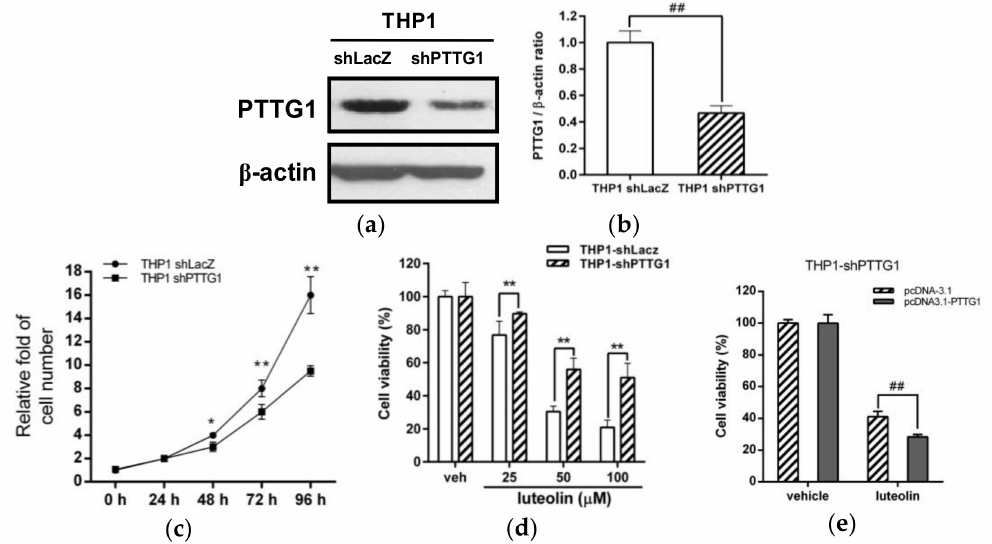
Figure 5. Effects of PTTG1 knockdown on cell proliferation and luteolin-induced cell death in THP-1 cells. ( a ) Control LacZ- and PTTG1-knockdown THP-1 cells (THP1 shLacZ and THP1 shPTTG1) were generated as described in the Materials and Methods. The PTTG1 and β -actin protein levels were determined by Western blot analysis. The experiments were triplicated, and a representative blot is shown. ( b ) The intensity of PTTG1 versus β -actin is normalized and presented as the mean ± SD of triplicated experiments. ## p < 0.01 represents a significant difference compared to the shLacZ control cells (THP1 shLacZ group). ( c ) Cells were stained with trypan blue, and cell numbers were measured by counting viable cells at the 0-, 24-, 48-, 72- and 96 h time points, respectively. The experiments were replicated at three times. * p < 0.05 and ** p < 0.01 represent a significant difference compared to the THP1 shLacZ group. ( d ) The shLacZ and shPTTG1 cells were treated with vehicle or luteolin (25–100 µ M) for 24 h, and cell viability was determined by MTT assay. The experiments were